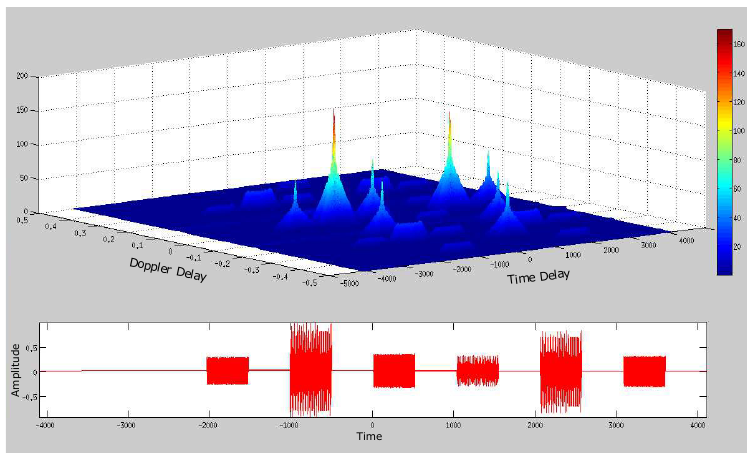
Figure 31. Multiple object tracking using MMPP “chirp pulses”, at Tracking Time 4, with no noise.